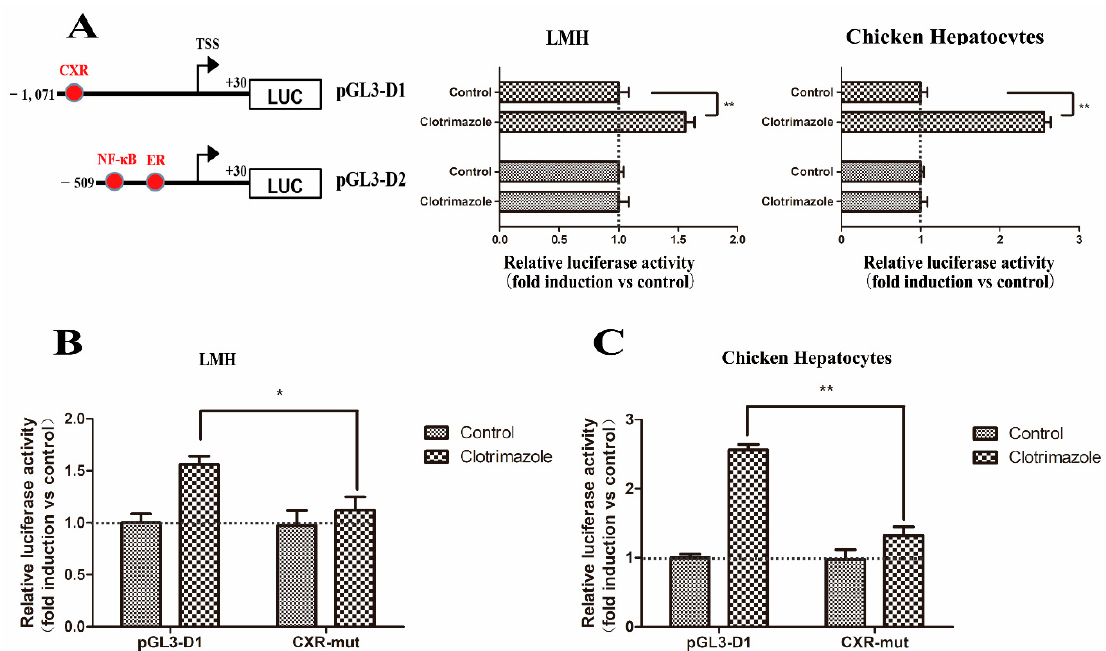
Figure 7. Regulation of chicken Abcg2 promoter activity by clotrimazole. ( A ) Isolation of the promoter elements responsible for mediating the stimulation of the Abcg2 gene promoter activity by clotrimazole. LMH cells and chicken hepatocytes were transfected with deletion constructs of the Abcg2 promoter. A schematic illustration of the Abcg2 gene promoter reporter plasmids used is shown in the left panel. A point mutation was introduced into the pGL3-D1 construct. ( B ) LMH cells and ( C ) chicken hepatocytes were transfected with each mutant. The fold increase in the luciferase activity by clotrimazole treatment of each construct is indicated. * represents p < 0.05 and ** represents p < 0.01.